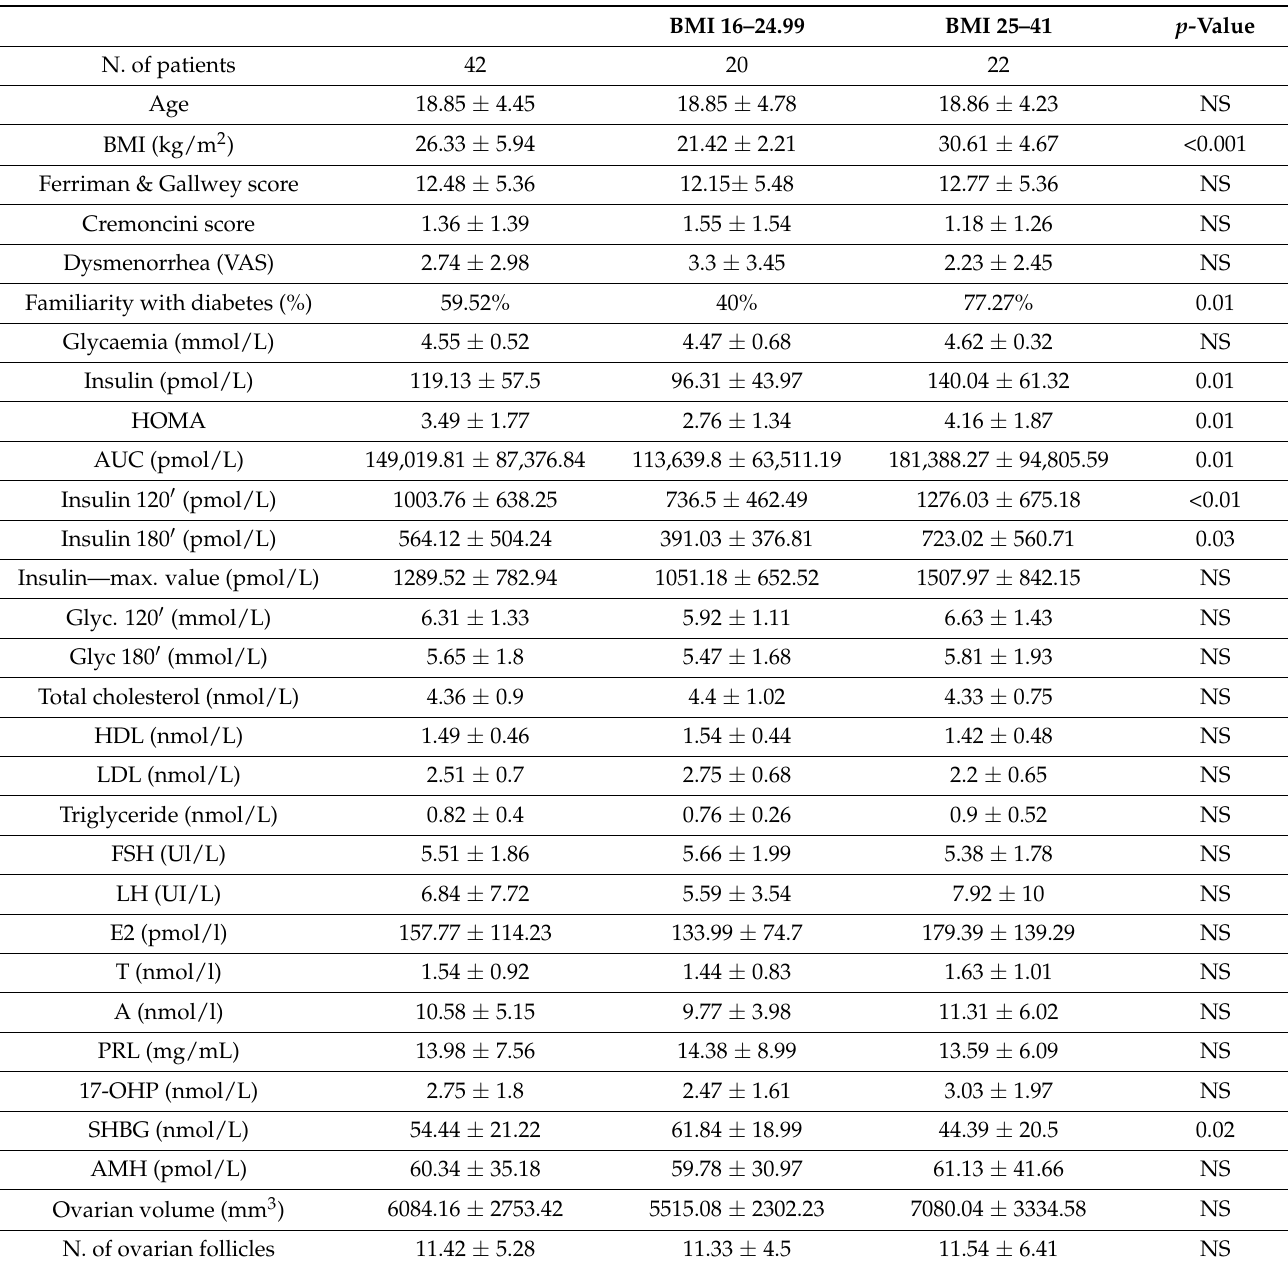
Table 1. Anthropometric, hormonal and metabolic characteristics of all patients and in two subgroups in relation to BMI. Values are mean ±